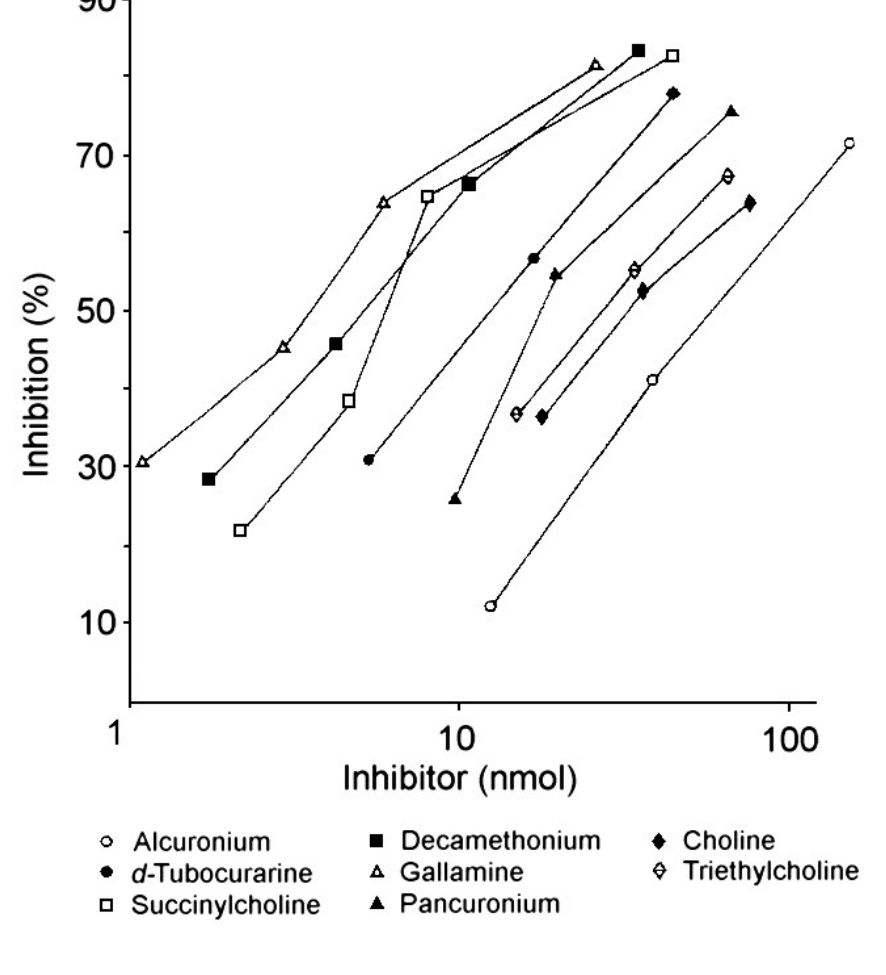
Figure 15. Demonstration of recognition of NMBDs by IgE antibodies in serum from a patient allergic to gallamine and dose-dependent inhibition results showing strong inhibition by gallamine and cross-reactions between the drugs using a triethylcholine- Sepharose covalent complex as solid phase in the immunoassay. Refer also to Table